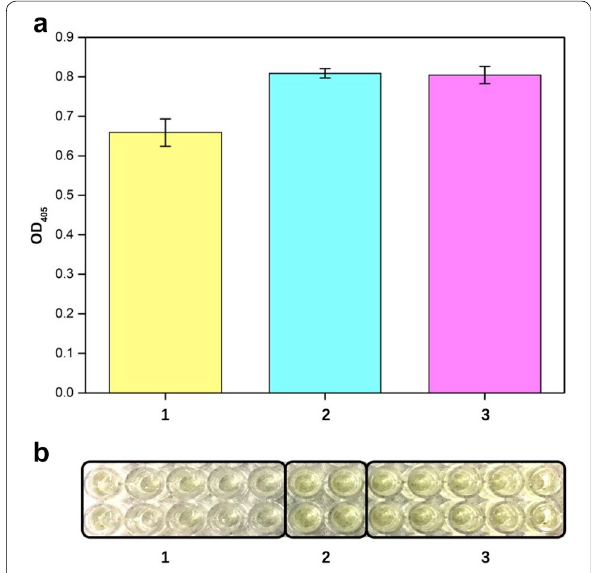
Fig. 3 Effect of bacterial cell lysate on the GSH content analysis in LigF reaction system. a Absorbance value OD 405 ; b 96-Well Microplate. 1. The bacterial cell lysate: BL21(DE3) with ligF plasmid; 2. without bacterial cell lysate; 3. the bacterial cell lysate: BL21(DE3) without plasmid. In this part, a 96-Well Microplate was used to investigate the effect of cell lysate on assay of LigF activity by GSH analysis. In No. 1 group, the reaction mixture was 200 μL in total, including 4 μL 20 mM GVG, 4 μL 3 mg/mL GSH, 20 μL cell lysate from BL21(DE3) with ligF plasmid, 172 μL 50 mM Tris–Cl buffer (pH 8.0); in the No. 2 group, 20 μL cell lysate was replaced by the 20 μL 50 mM Tris–Cl buffer (pH 8.0); in the No. 3 group, the cell lysate was from BL21(DE3) strain without plasmid. The mixture was cultured at 27 °C,80 rpm for 30 min. And then, 50-μL sample was taken for the GSH content analysis to describe the LigF